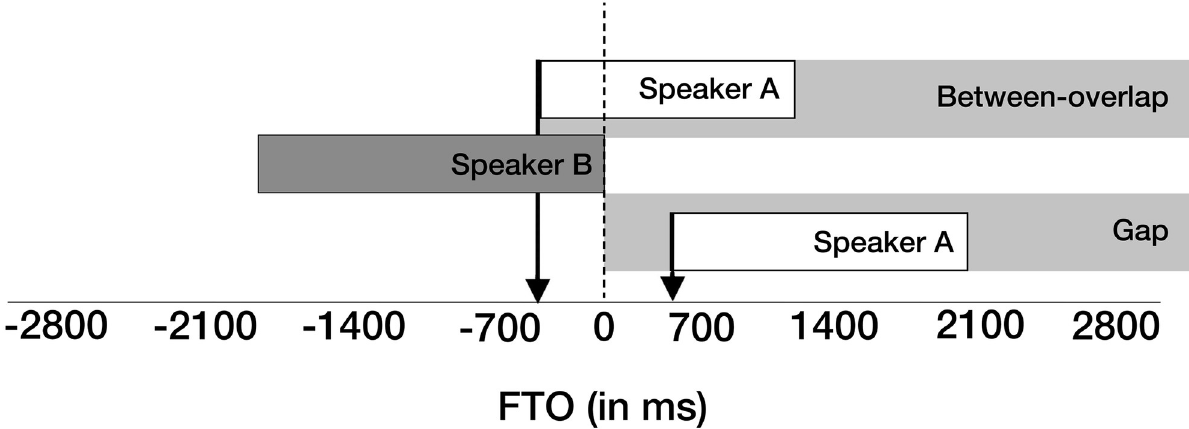
Fig 3. Categories and measurement of turn transitions. “Gaps” are silent intervals between turn transitions; “between-overlaps” are turn transitions composed of overlapping speech from both interlocutors. Gaps are represented with positive Floor Transfer Offset (FTO) values (see right arrow for an FTO value of about +600 ms); overlaps are represented with negative FTO values (see left arrow for an FTO value of about -600 ms).